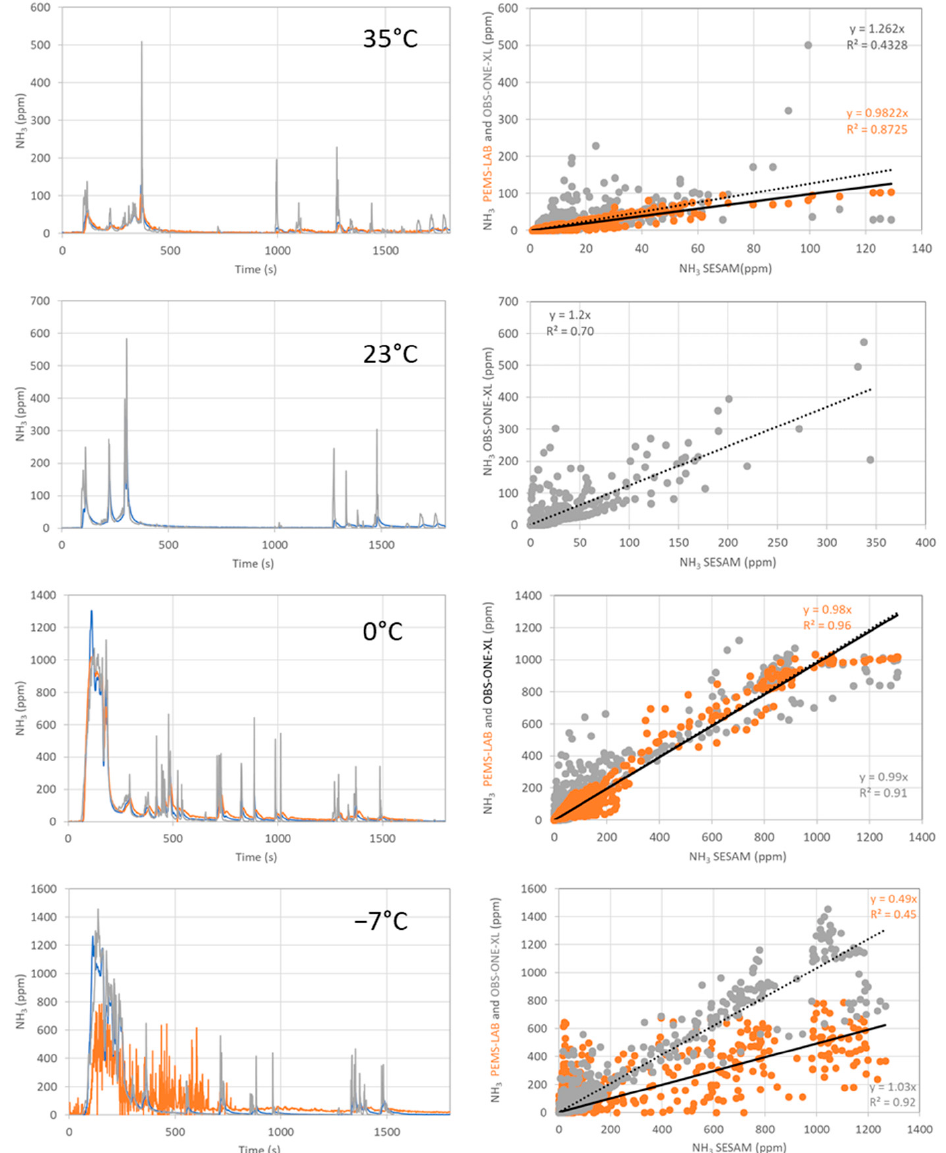
Figure 4. ( Left panels ) NH 3 emission profiles measured using the SESAM (blue), PEMS-LAB (orange) and OBS-ONE-XL (grey) over the WHVC at 35 ◦ C, 23 ◦ C, 0 ◦ C and − 7 ◦ C. ( Right panels ) Correlation of the NH 3 concentrations measured by the SESAM plotted against the NH 3 concentrations measured by the PEMS-LAB (orange) and against the OBS-ONE-XL (grey). The PEMS-LAB’s trend line is represented by a solid black line and the OBS-ONE-XL’s trend line is represented by a dashed black line.